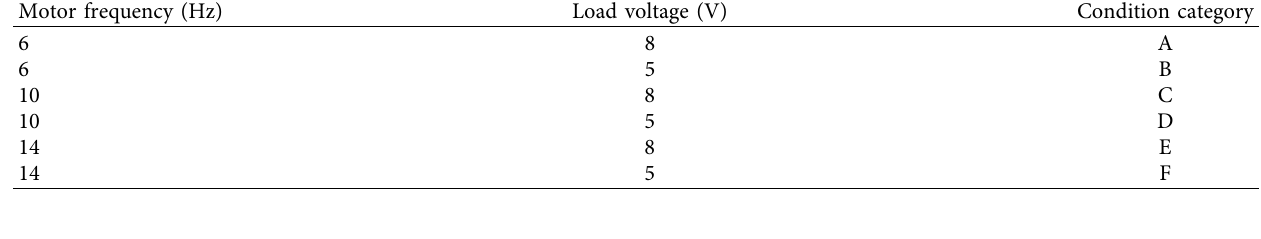
Figure 7: The structure of WTDDS (1, brake; 2, planetary gearbox; 3, shaft gearbox; 4, motor; 5, four sensors (from left to right: vibration, force, vibration, and torque); 6, windmill). Table 3: Working conditions settings.